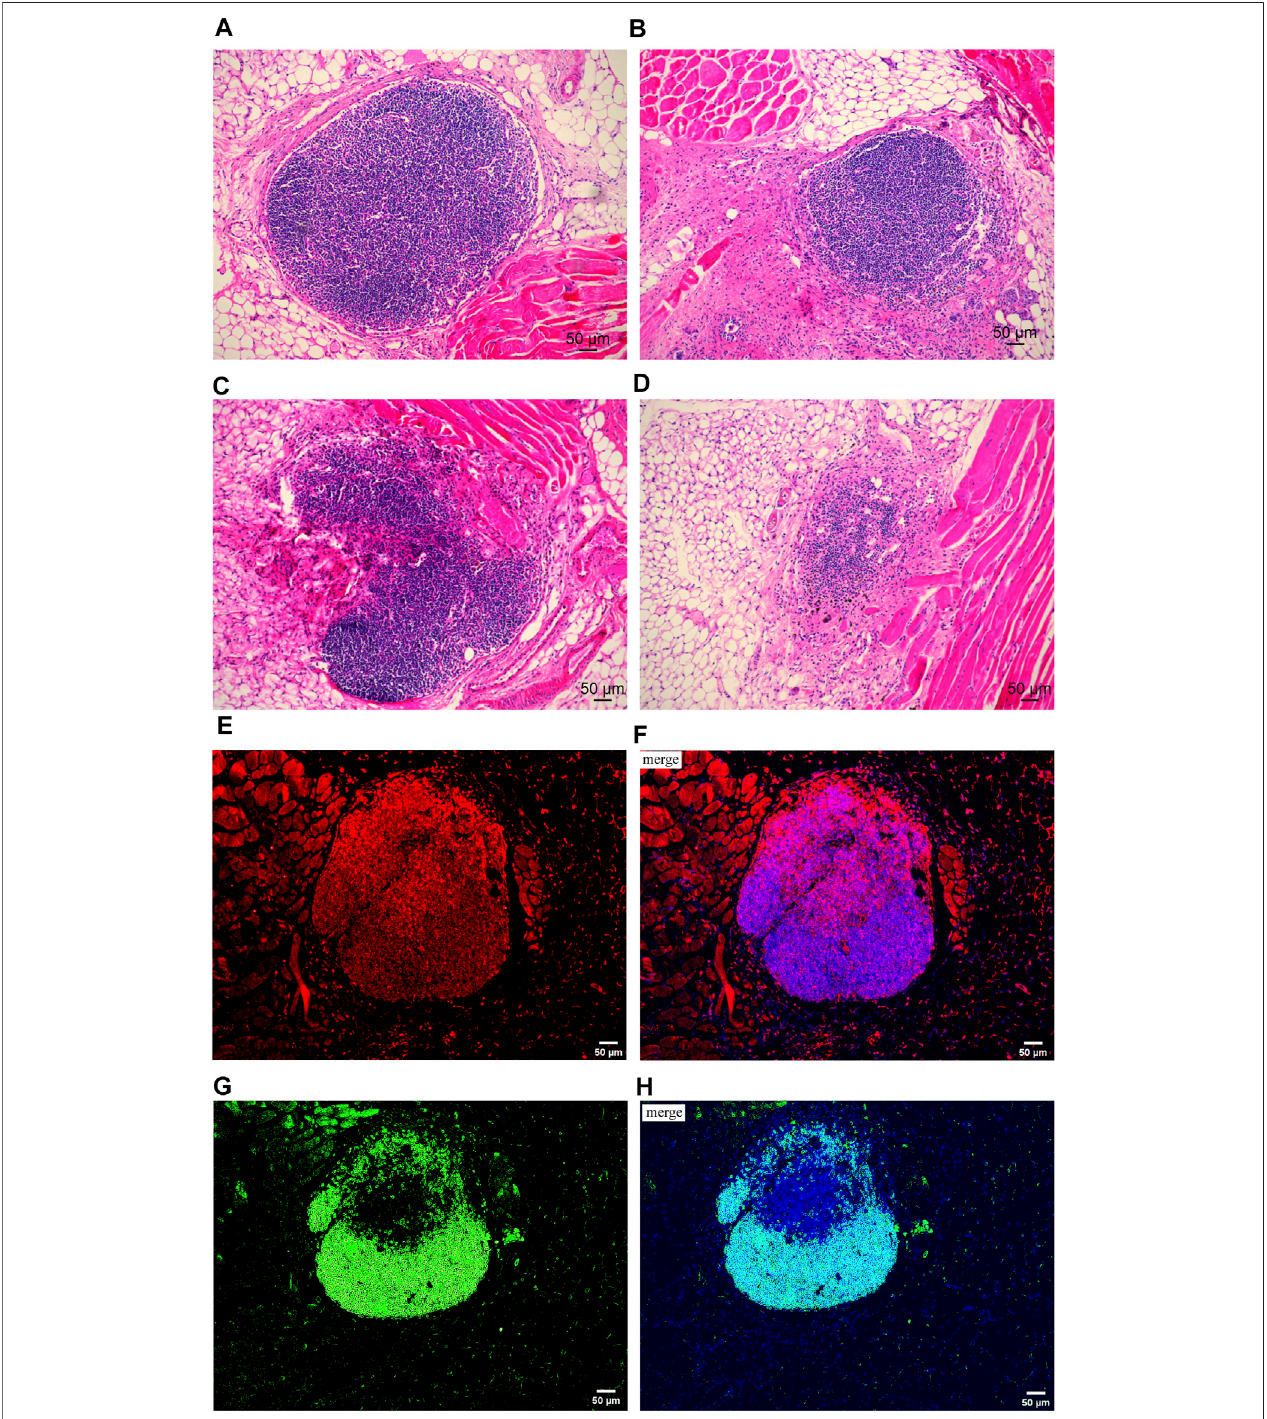
FIGURE 2 | Hematoxylin and eosin staining on transplanted lymph nodes and immuno fl uorescence staining on T cells and B cells. (A) Example of normal node ranked3. (B) Exampleofnoderanked2,nodeswithsomeabnormality(evidenceofischemicdamageandlossofcellularity). (C) Exampleofnoderanked1,partialnodes or nodes with severe damage. (D) Example of node ranked 0, lymph nodes absent (tissue resorbed). (E,F) Distribution of T cells in transplanted lymph nodes. (E) Red fl uorescence represented CD3 + cells (T cells) and (F) was the merged image; the red fl uorescence represented target protein CD3, and the blue fl uorescence represented cell nucleus. (G,H) Distribution of B cells in transplanted lymph nodes. (G) Green fl uorescence represented CD45 + cells (B cells) and (H) was the merged image; the green fl uorescence represented target protein CD45, and the blue fl uorescence represented cell nucleus.